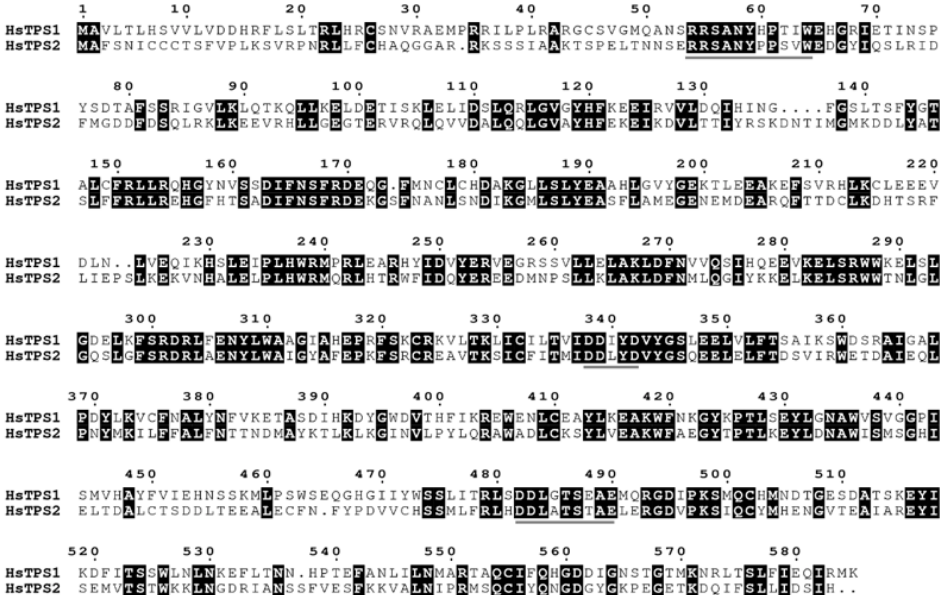
Figure 1. Protein sequence alignment of the two HsTPS was constructed using ClustalW and was edited using Escript 3.0. The three conserved motifs, RRx8W, DDxxD, and DDxxTxxxE, characteristic of terpene synthases, were overlined in gray.